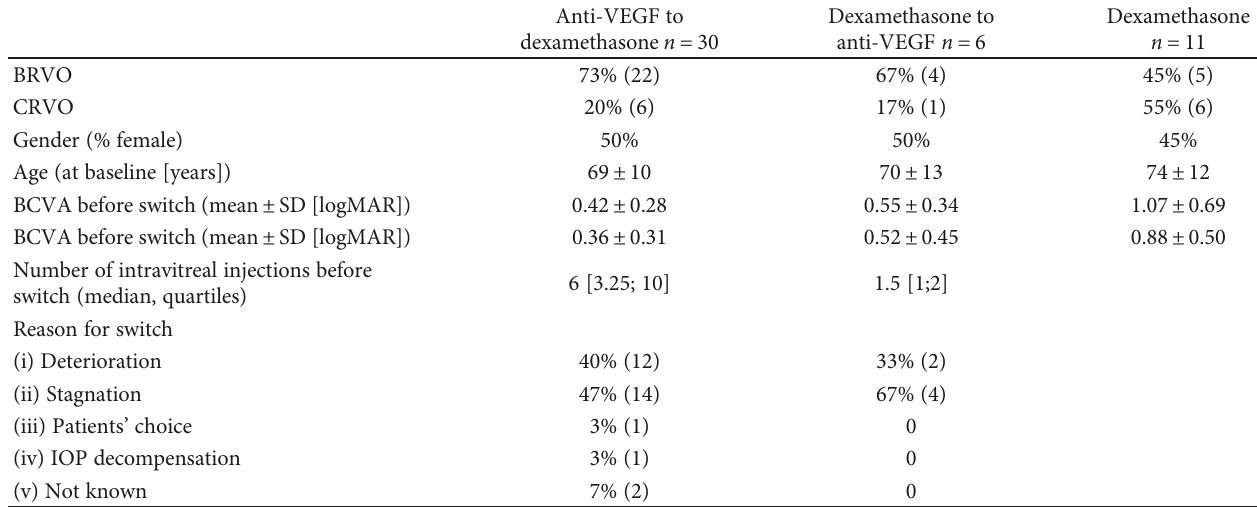
Table 1: Patients ’ baseline characteristics and reason for switch of intravitreal therapy.